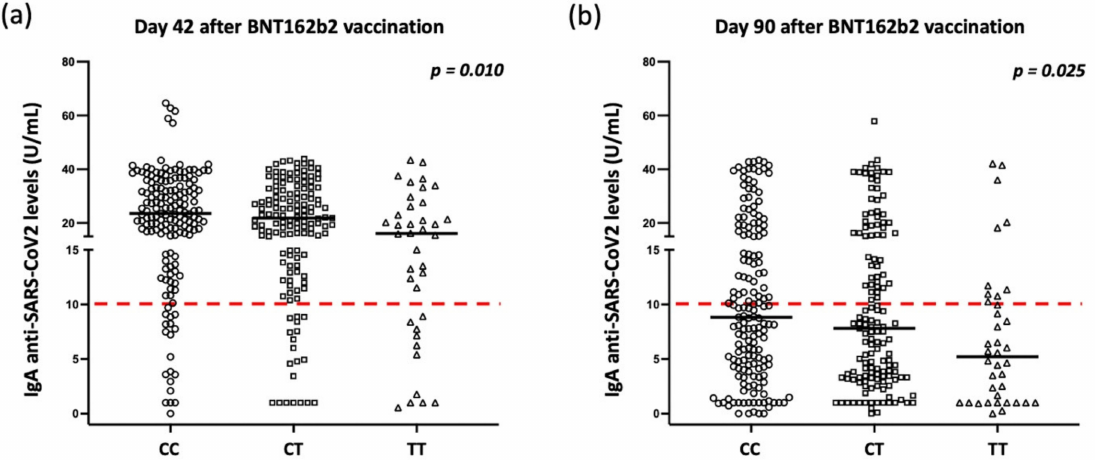
Figure 1. Serum IgA levels according to the status of CD40 rs1883832 polymorphism for participants vaccinated with the BNT162b2 mRNA vaccine ( a ) on day 42 after the first vaccination and ( b ) on day 90 after the first vaccination. Black lines indicate the median values, and red dotted lines represent the cut-off of positive anti-SARS-CoV-2 IgA (10 U/mL) antibodies. The statistical analysis was performed by Kruskal–Wallis H